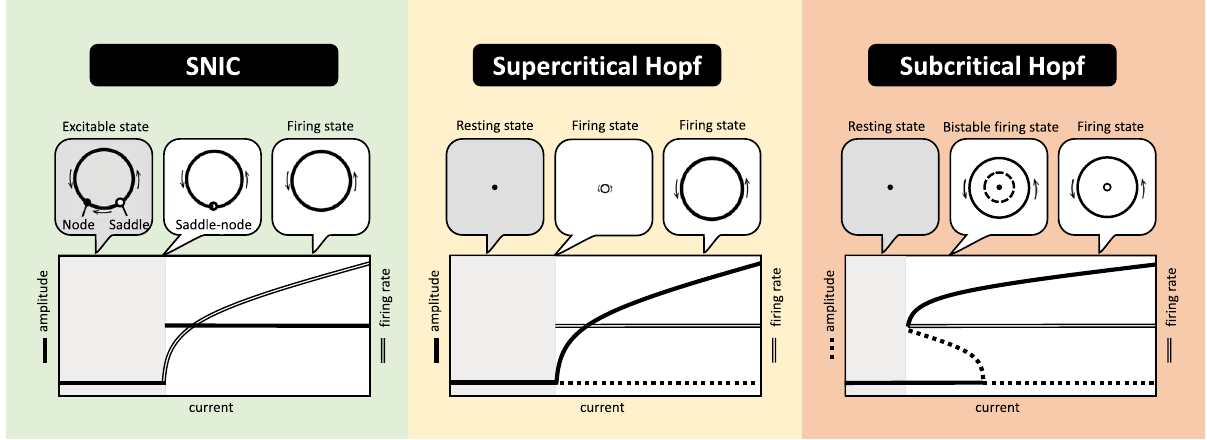
Figure 5. Dynamical phase transitions in the U(1) neuron: SNIC, supercritical Hopf, subcritical Hopf. The upper panels present the topological structures of the limit cycles and the fixed points in the vicinity of the dynamical phase transitions. The firing amplitude and rate of the neuron versus external current stimulus are illustrated in the bottom